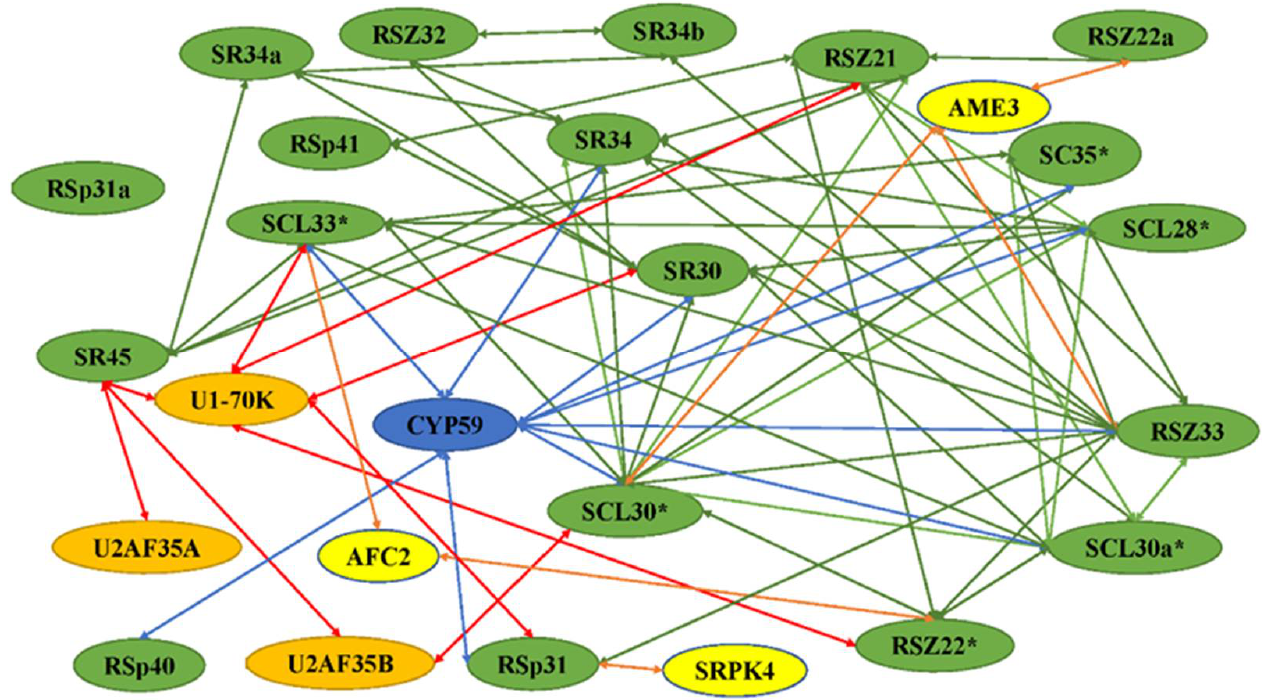
Figure 2. Network of interactions among SR proteins and other spliceosomal proteins. These inter- actions were identified using yeast two-hybrid analysis and/or in vitro protein–protein interaction assays. The interaction of SR protein with itself is indicated by asterisks. The green, red, orange, and blues arrows indicate the SR proteins interacting with SR proteins, splicing factors, protein kinases, and cyclophilin-like proteins, respectively. All SR proteins are shown in green. The snRNP proteins U1 and U11, and splicing factor U2af small subunits U2AF35A and U2AF35B are indicated in orange. Protein kinases and cyclophilin-like proteins are shown in blue and yellow, respectively. The SR proteins are involved in the spliceosome by interacting with snRNPsas splicing factors, and many interactions with themselves or other SR proteins have been revealed (Figure 2). The splicing of nuclear pre-mRNAs takes place in a multi-component complex called the spliceosome (Figure 3). Normally, the proteins form a major spliceosome, which consists of a pre-mRNA, five snRNPs, and other non-snRNP splicing factors including SR proteins. The atSR45a-1a and atSR45a-2 proteins interact with U1-70K and U2AF 35 b during spliceosome assembly. The two isoforms also interact with themselves, other SR proteins, and PRP38-like protein [15]. Like the major spliceosome, most SR proteins have been found to interact with U11-35K, form minor spliceosomes, and play a role in splicing of minor introns [16]. The co-localization in nuclear speckles, and the interaction and co-expression between U2AF65a and SC35/SCL proteins have been observed, indicating the relationships between snRNP and SR proteins for the spliceosome